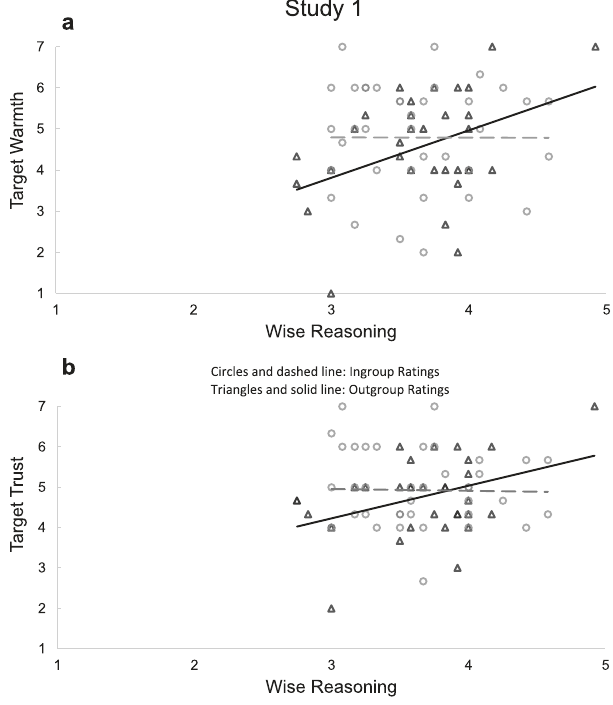
Fig. 1 Results from Study 1: positivity toward target group as a function of participants ’ self-reported ingroup or outgroup membership and their level of wise reasoning. a Warmth ratings. b Trust ratings. One outlier was removed for ease of presentation; see Fig. S9 for a Figure including the outlier. M wise reasoning = 3.59, SD = 0.56.